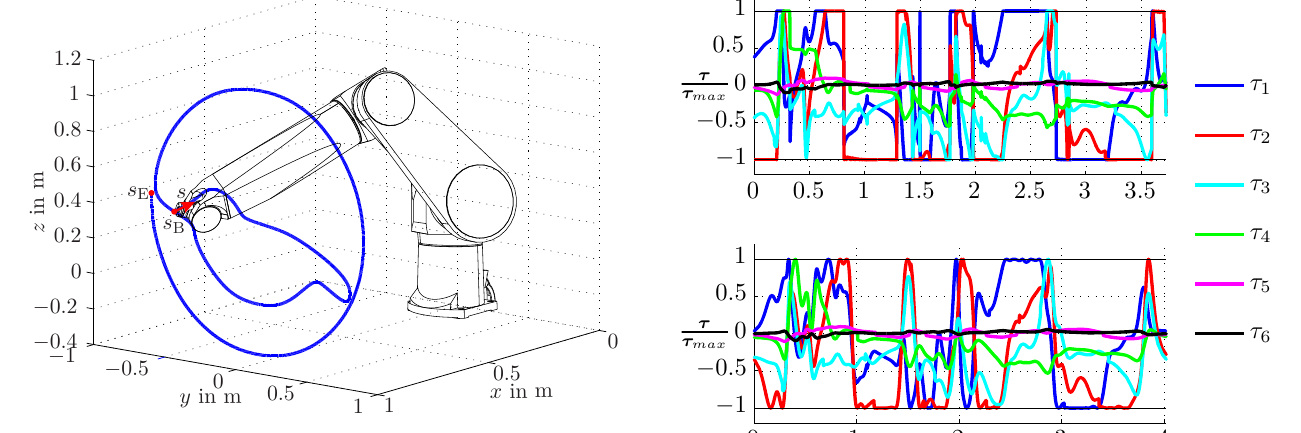
Figure 7. Geometric path – logo of the Institute of Robotics at the JKU Linz.